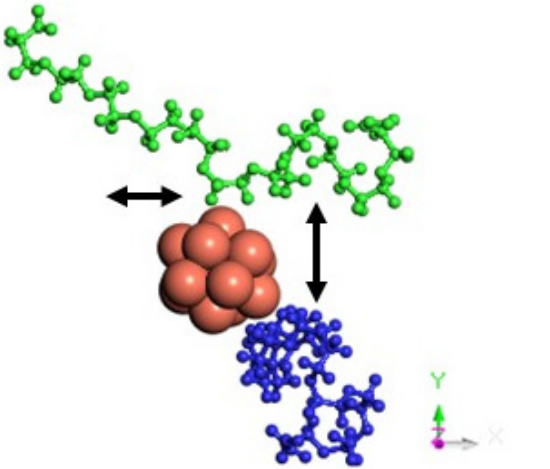
Nanomaterials 2021 , 11 , 1378 12 of 16 Figure 11. Total MSD (black) and MSD in x, y, and z directions of the clusters interacting with pristine and functionalized graphene nanoplatelets. Axis units: Time in ps (x), MSD in Å 2 (y).